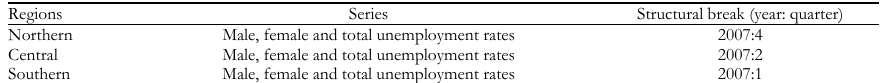
Estimated break dates by monitoring test approach in unemployment rates Regions Series Structural break (year: quarter)